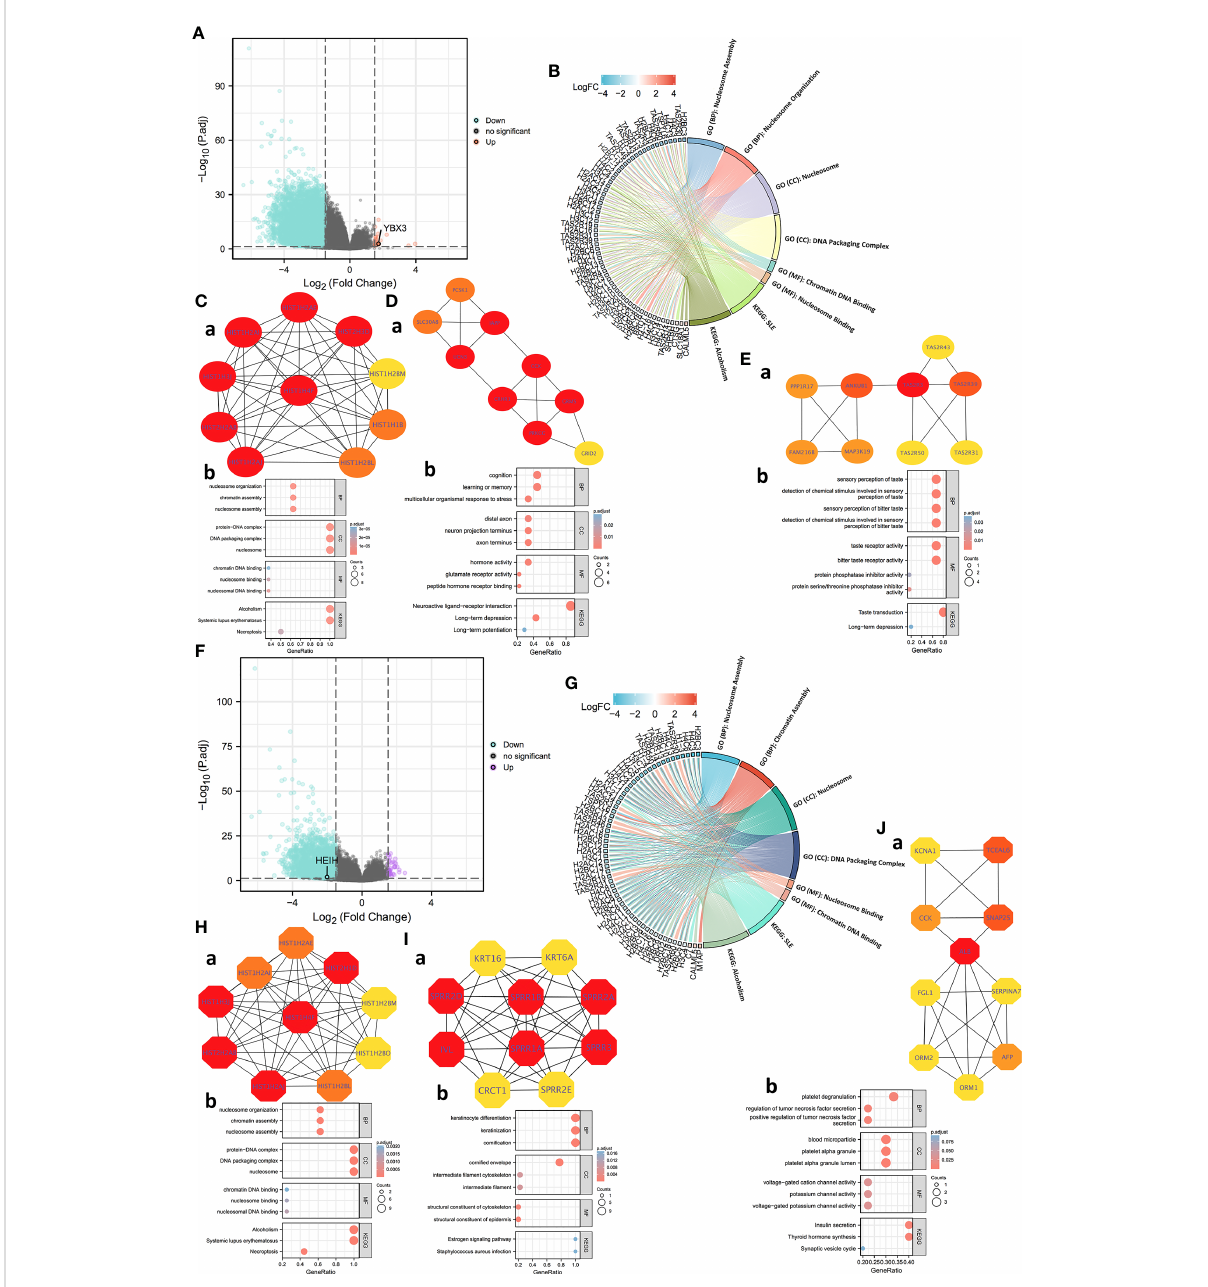
FIGURE 4 Protein – protein interaction (PPI) network construction and Gene Ontology (GO) and Kyoto Encyclopedia of Genes and Genomes (KEGG) analyses of differentially expressed genes (DEGs) between HEIH/YBX3 high-expression and low-expression groups in COAD. (A) Volcano map of DEGs of HEIH expression in COAD (red: upregulation; blue: downregulation). (B) GO and KEGG pathway enrichment analyses of DEGs of HEIH in the form of a chordal graph. (C, a) Hub genes of PPI network (ranking fi rst) and MCODE2 components identi fi ed in the gene lists. (C, b) Enrichment analysis of the hub gene network. (D, a) Hub genes of PPI network (ranking second) and MCODE2 components identi fi ed in the gene lists. (D, b) Enrichment analysis of the hub gene network. (E, a) Hub genes of PPI network (ranking third) and MCODE2 components identi fi ed in the gene lists. (E, b) Enrichment analysis of the hub gene network. (F) Volcano map of DEGs of YBX3 expression in COAD (purple: upregulation; blue: downregulation). (G) GO and KEGG pathway enrichment analyses of DEGs of YBX3 in the form of a chordal graph. (H, a) Hub genes of PPI network (ranking fi rst) and MCODE2 components identi fi ed in the gene lists. (H, b) Enrichment analysis of the hub gene network. (I, a) Hub genes of PPI network (ranking second) and MCODE2 components identi fi ed in the gene lists. (I, b) Enrichment analysis of the hub gene network. (J, a) Hub genes of PPI network (ranking third) and MCODE2 components identi fi ed in the gene lists. (J, b) enrichment analysis of the hub gene